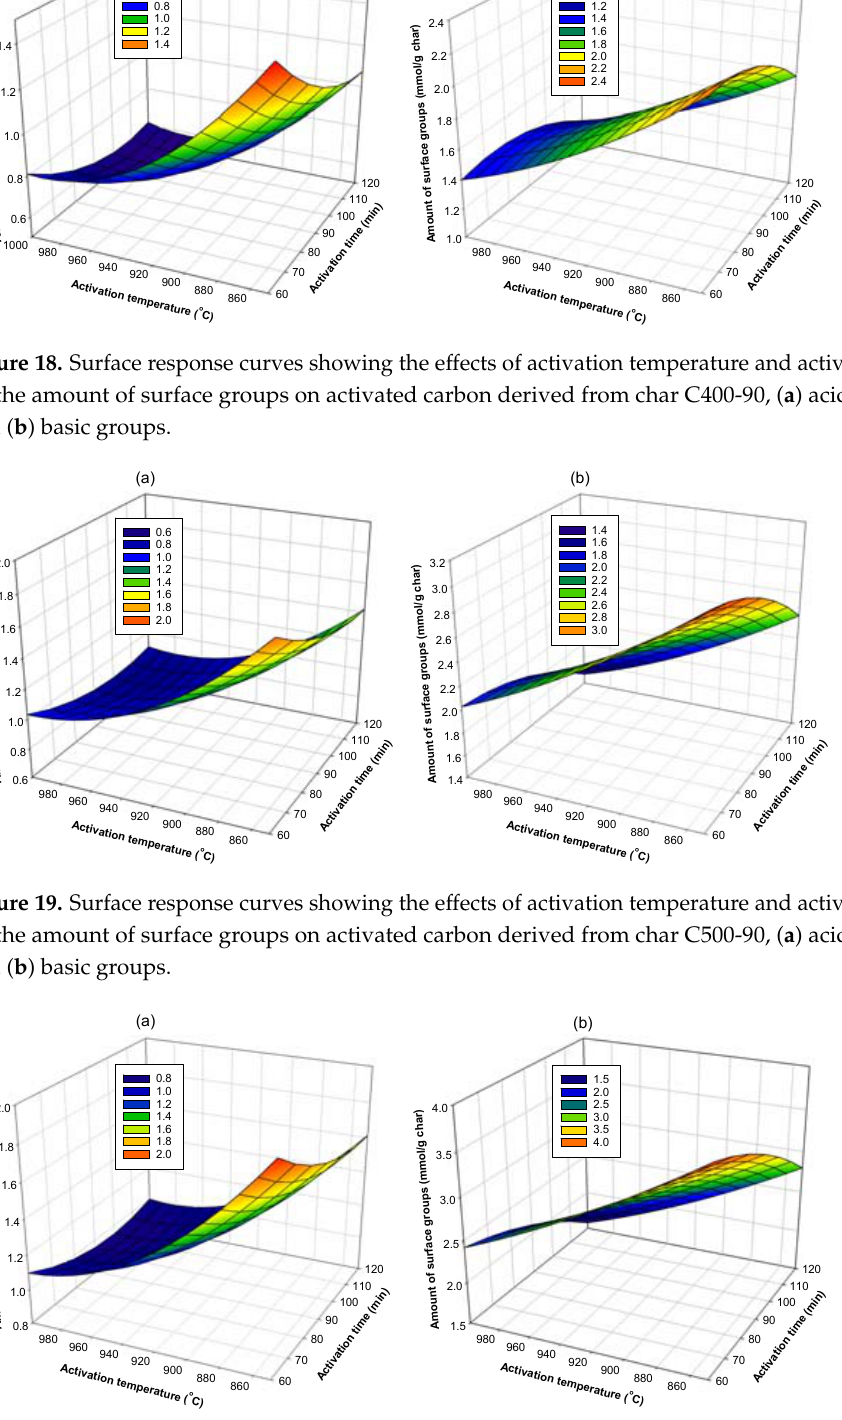
Figure 20. Surface response curves showing the effects of activation temperature and activation time